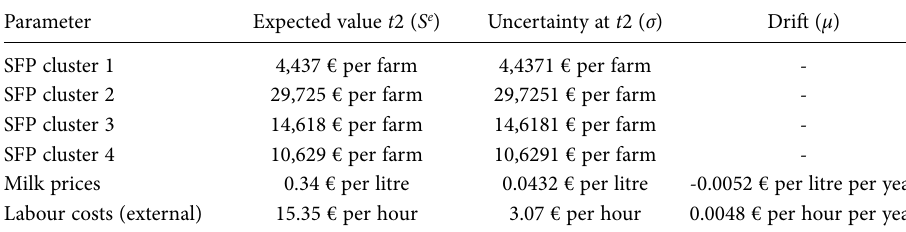
Table 2. Descriptive statistics of the stochastic